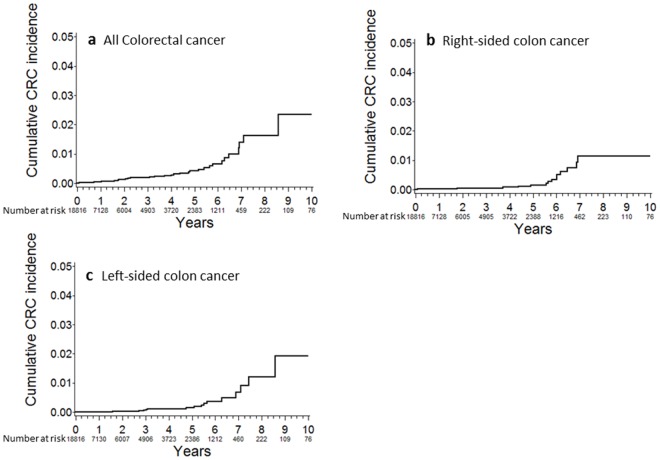
Cumulative colorectal cancer incidence.(a) All colorectal cancer; (b) Right-sided colon cancer; (c) Left-sided colon cancer.